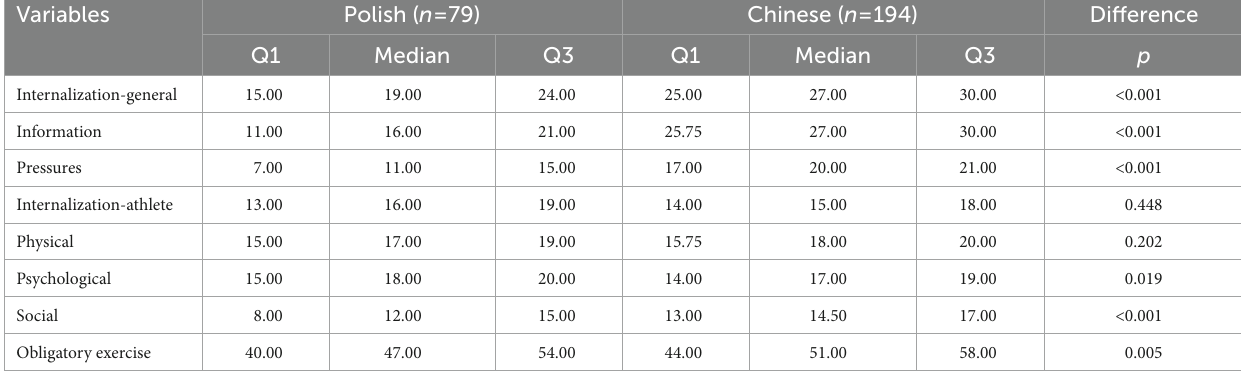
TABLE 1 Comparative analysis of the Polish and Chinese young male groups according to the variables included in the research model. Variables